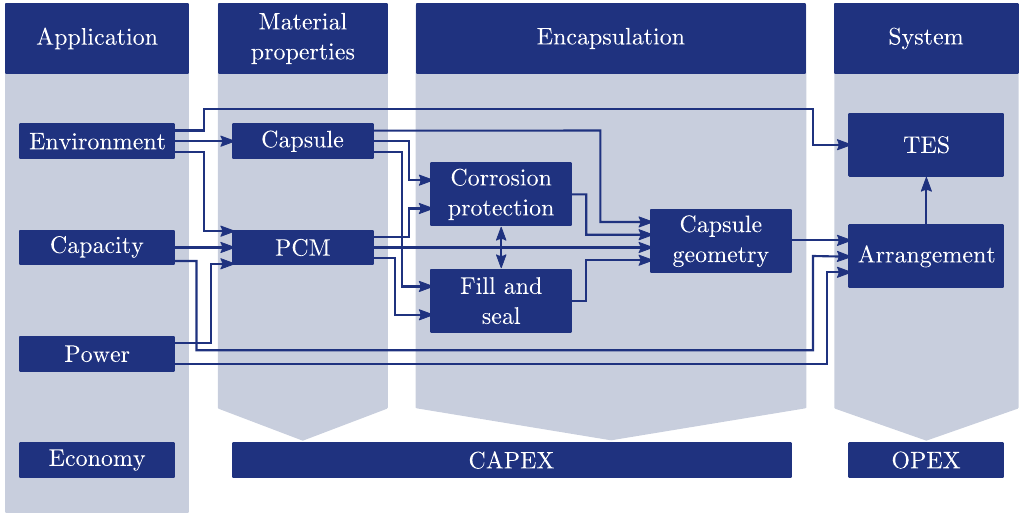
Figure 1. Workflow for the development of a macro-encapsulated thermal energy storage system consisting of metal capsules. The interconnections are described in detail in the corresponding sections.